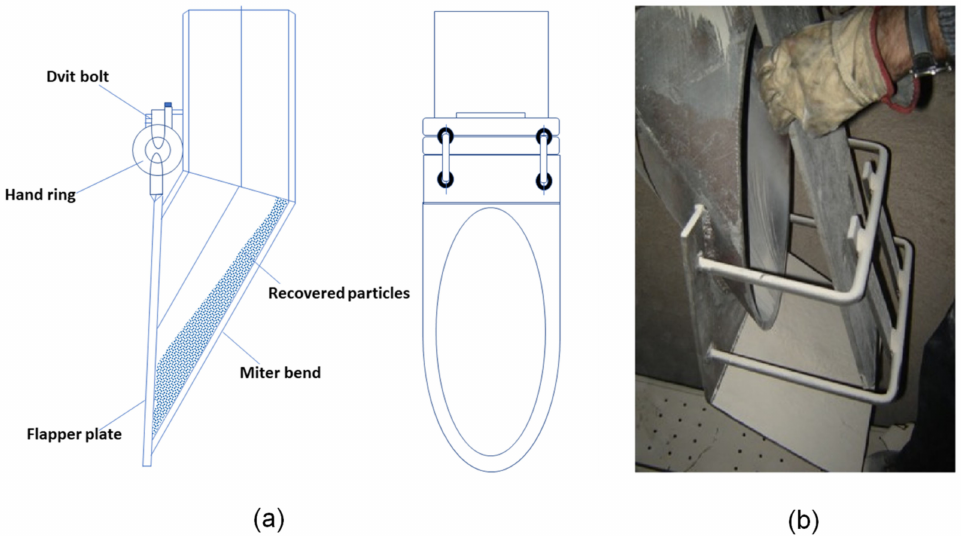
Figure 26. ( a ) Schematic diagram of cyclone trickle valve with free falling particle; ( b ) flapper section.